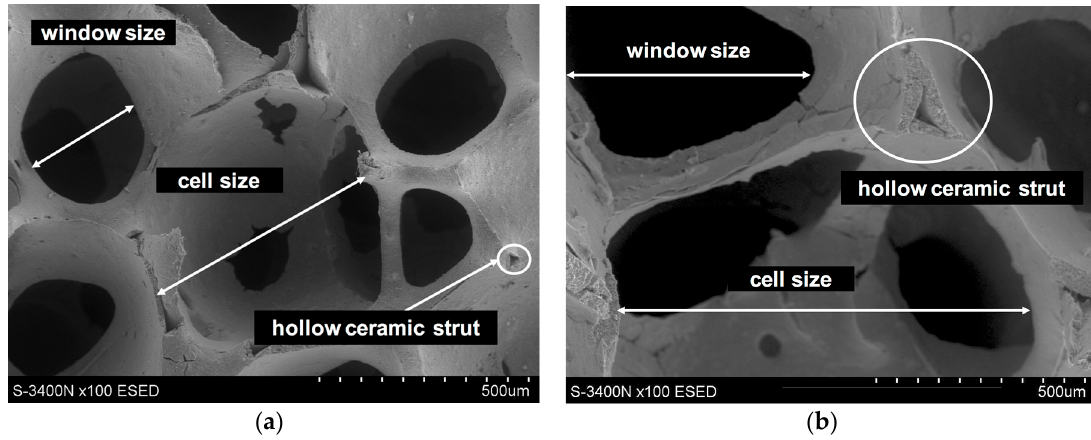
Figure 2. SEM micrographs of alumina oxide preforms used for centrifugal infiltration process by liquid AlSi alloy: ( a ) Al 2 O 3 _1; ( b ) Al 2 O 3 _2.